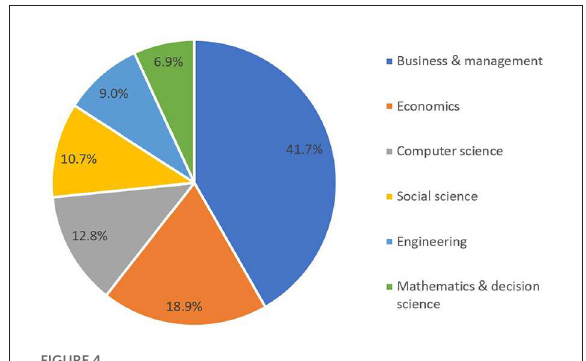
FIGURE4 Disciplines of scholarly literature on SME financial digitalization. Source: The